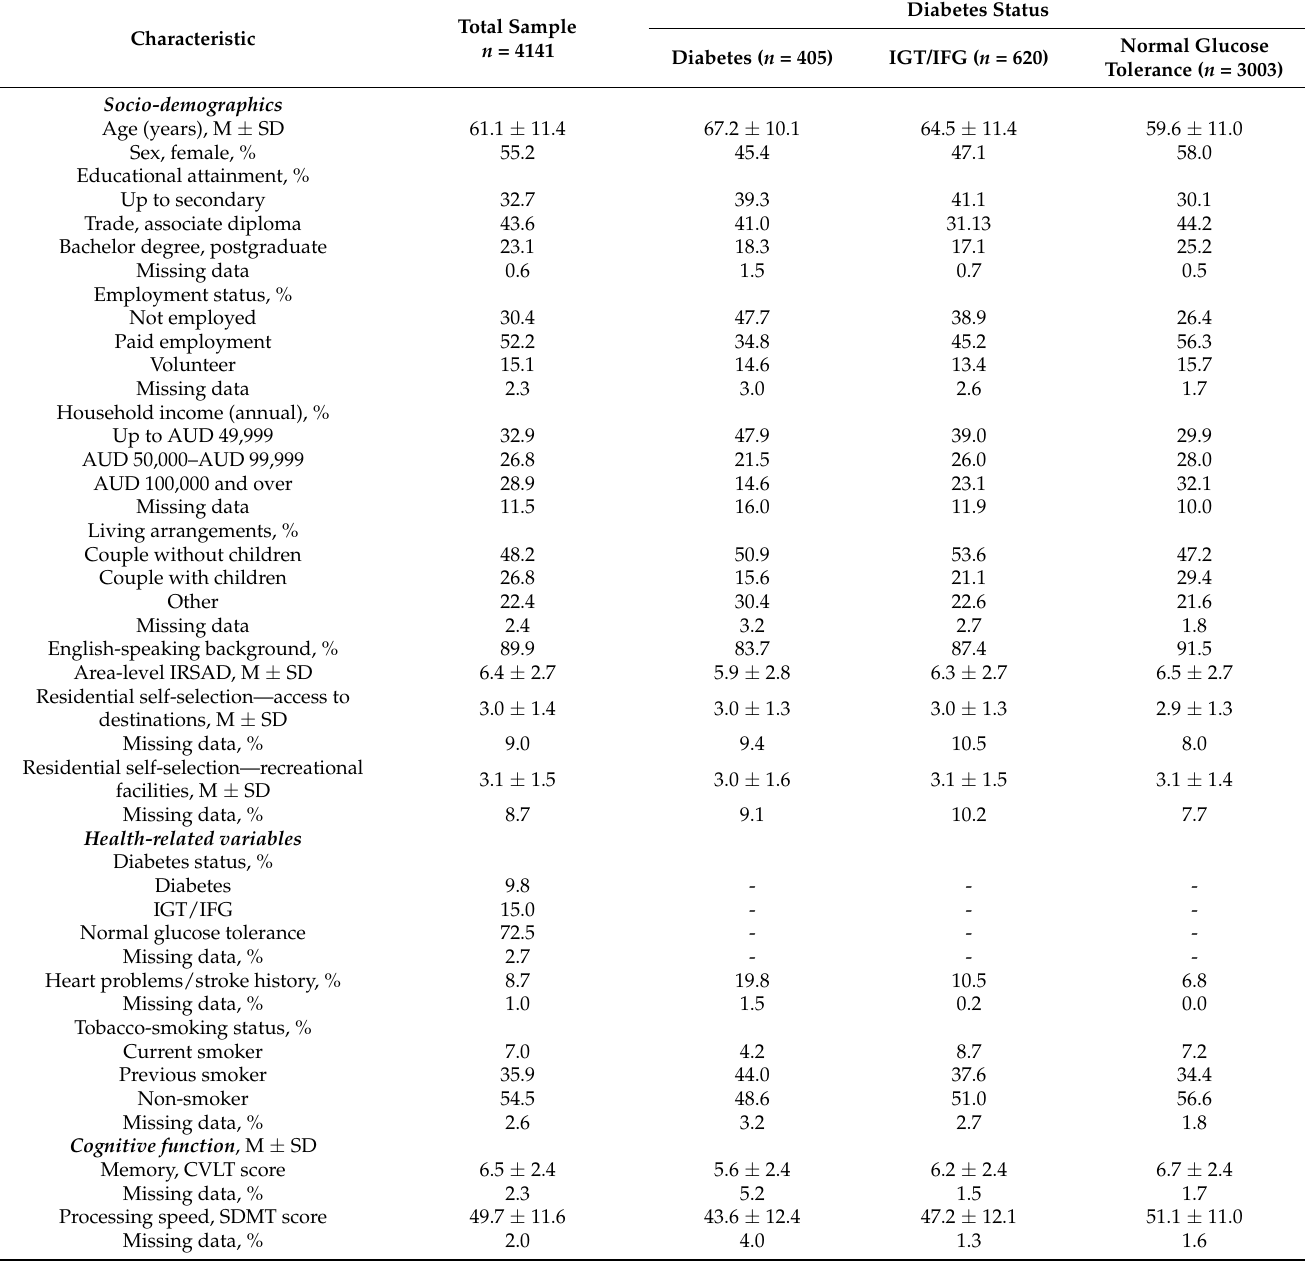
Table 1. Descriptive statistics of the AusDiab sample